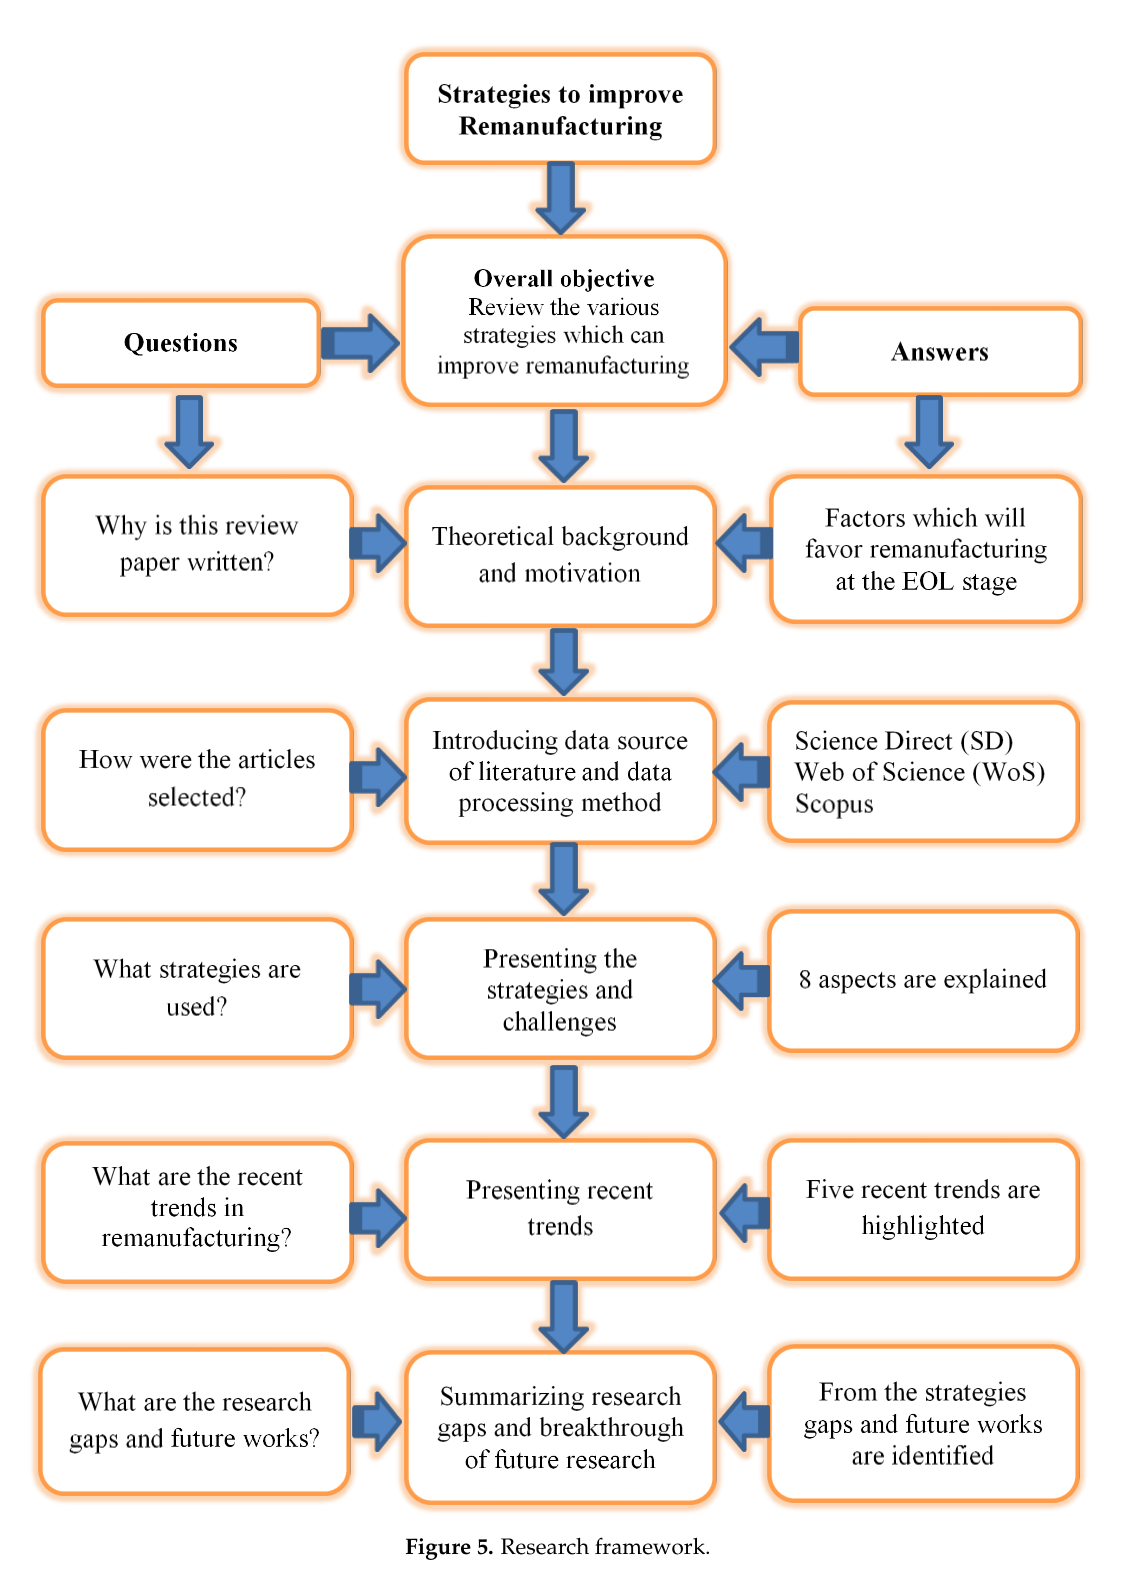
Figure 5. Research framework .